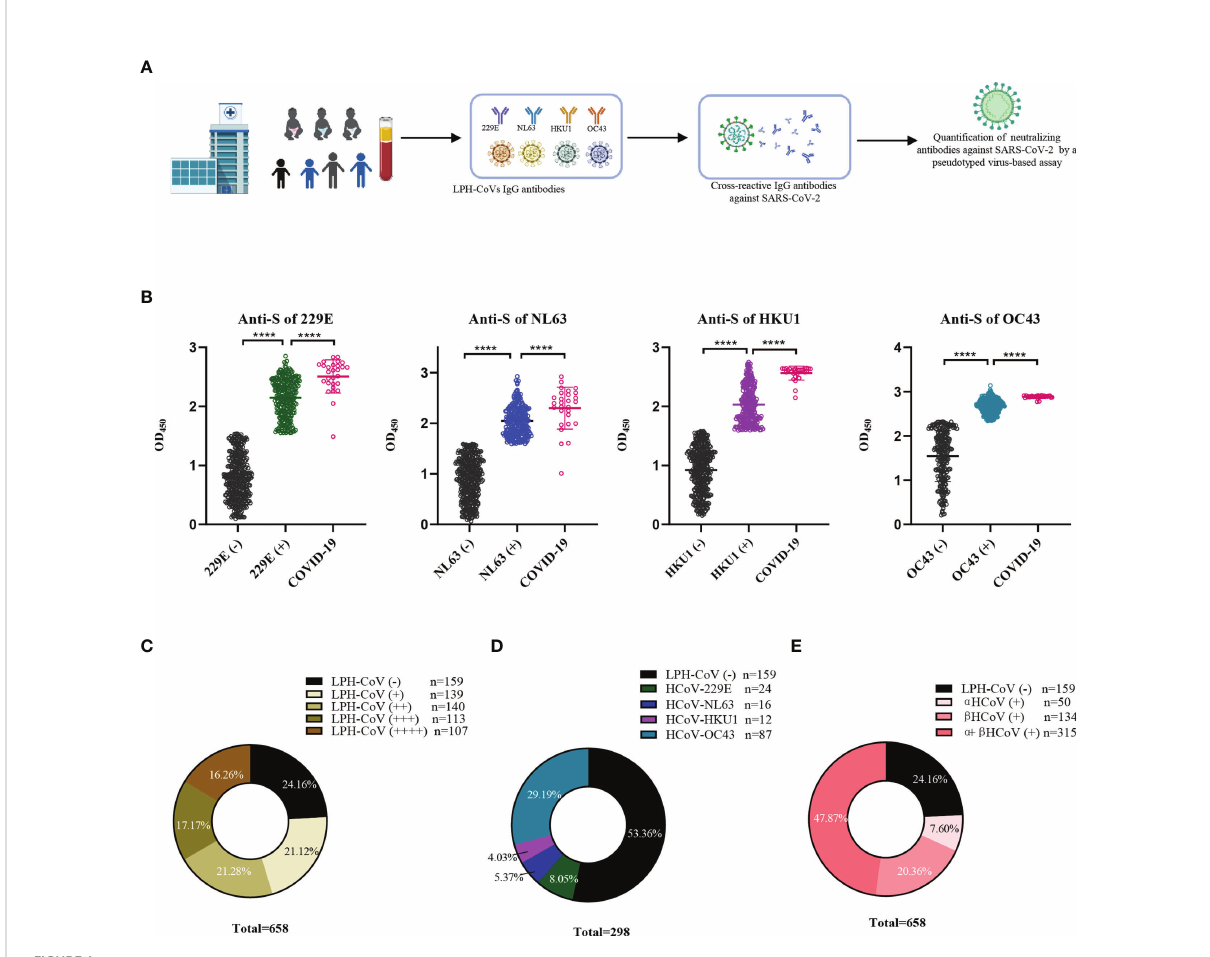
FIGURE 1 Identi fi cation of the pre-existing antibodies against LPH-CoVs in children ’ s serum samples (A) The schematic diagram of studying pre-existing antibodies against human coronavirus for the children cohort. (B) IgG antibodies response against the S protein of HCoV-229E, HCoV-NL63, HCoV-HKU1, and HCoV-OC43 was analyzed in 658 serum samples from hospitalized children prior to SARS-CoV-2 outbreak. The fi nite mixture model was used to de fi ne the individuals with positive values. 28 serum samples from convalescent COVID-19 patients were used as control. Student ’ s t test was used to compare the differences of medium values between groups, a two-tailed P value <0.05 was considered to be statistically signi fi cant, (**** P ≤ 0.0001). (C-E) The percentage of individuals with exposure to different LPH-CoVs (n=658) (C, E) or only one of the four LPH-CoVs (n=298) (D)